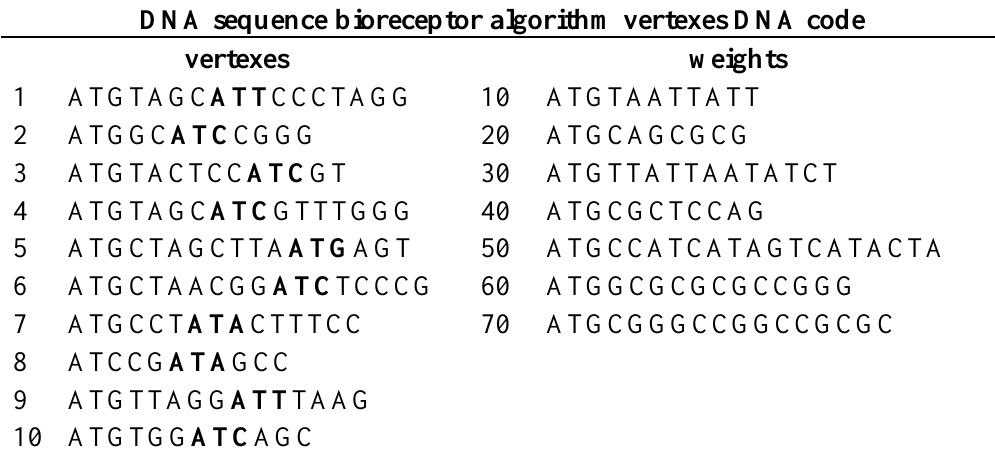
Table 5. DNA code for DNA sequence generating algorithm vertexes.